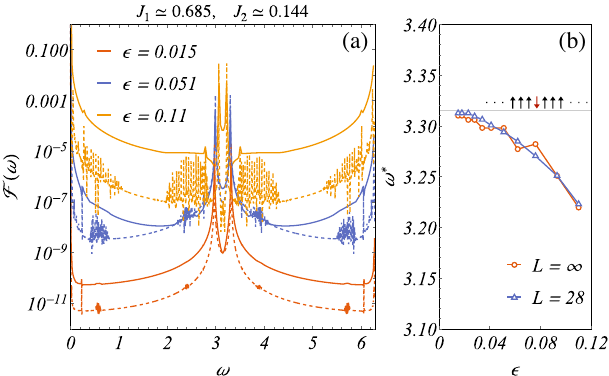
FIG. 13. (a) Discrete Fourier transform of the time series (up to 800 kicks) in Fig. 11 for representative values of the kick strength ϵ (solid lines). Dashed lines are the analogous data obtained via ED for L ¼ 28 and longer time series (up to 2000 kicks). (b) Position of the main peak (at ω > π ) as a function of ϵ , which is expected to match the “ classical ” single spin-flip excitation value for ϵ → 0 (see main text for